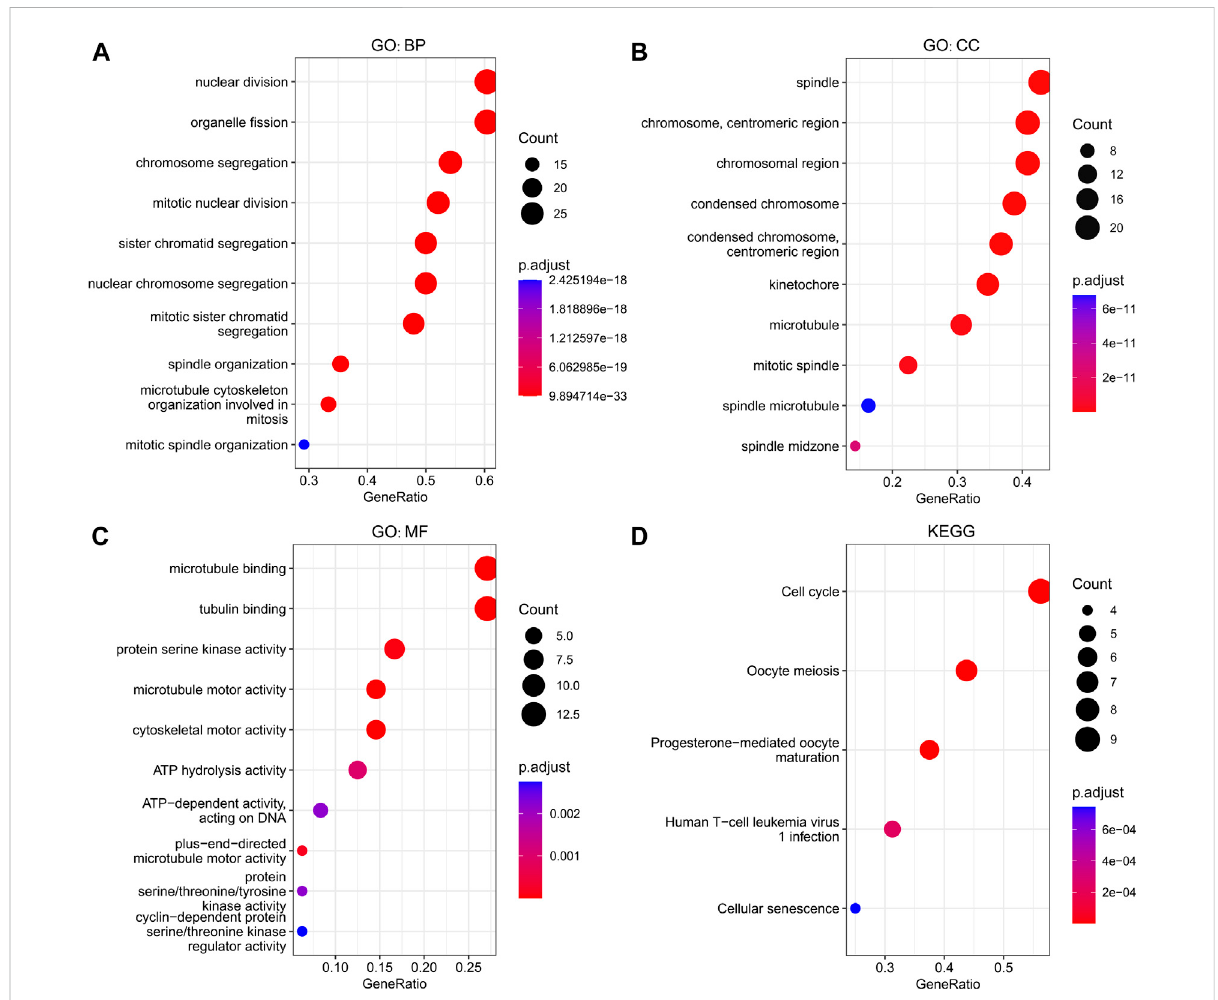
FIGURE 9 Functional enrichment analysis of GINS genes and their neighboring genes in SARC. Biological process (A) , Cellular component (B) , Molecular function (C) , and KEGG pathway (D) related to GINS1/2/3/4 and their neighboring genes in SARC.